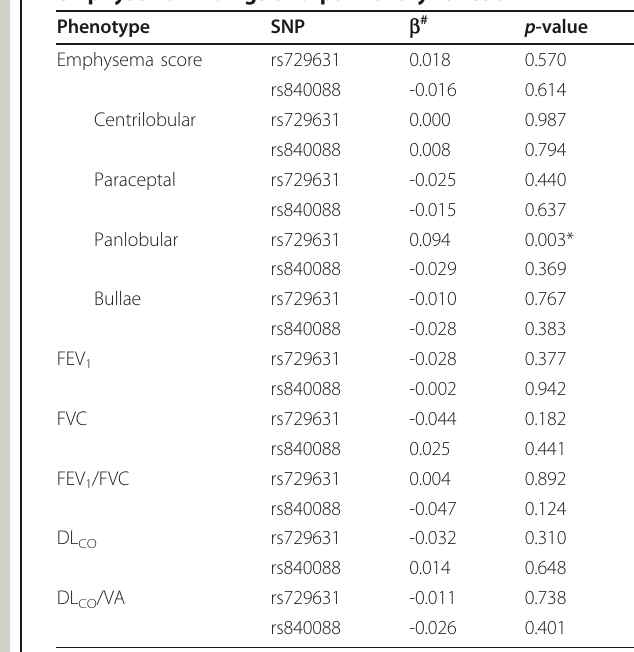
Table 2 Association between SERPINE2 polymorphisms, emphysema findings and pulmonary function